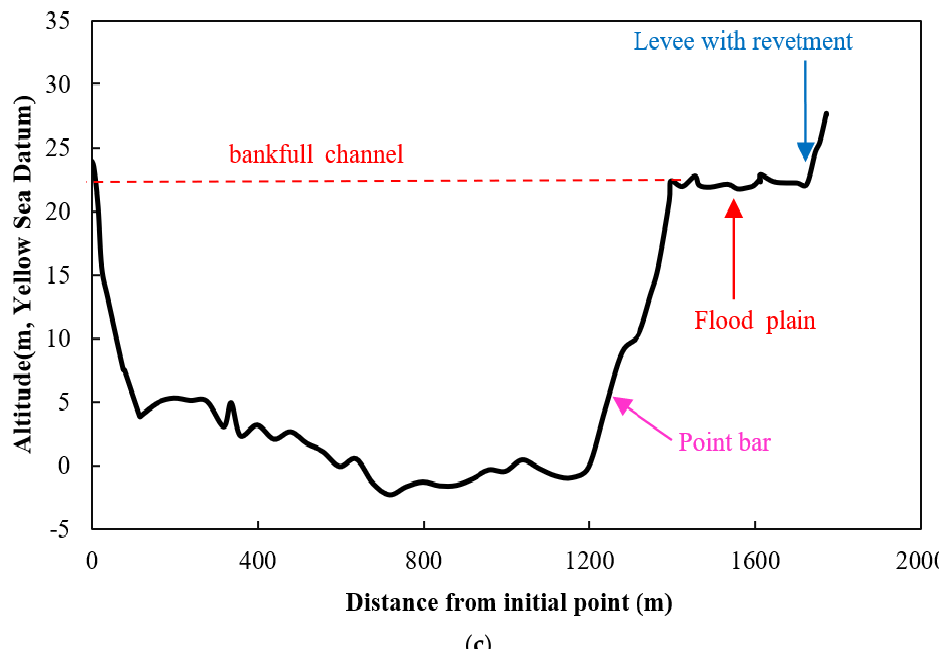
Figure 2. Bankfull channel morphology of three typical cross-sections. ( a ) HLZ09+1 (straight type), ( b ) 0HLZ16+1 (braided type), and ( c ) HLZ17+0 (curved type).